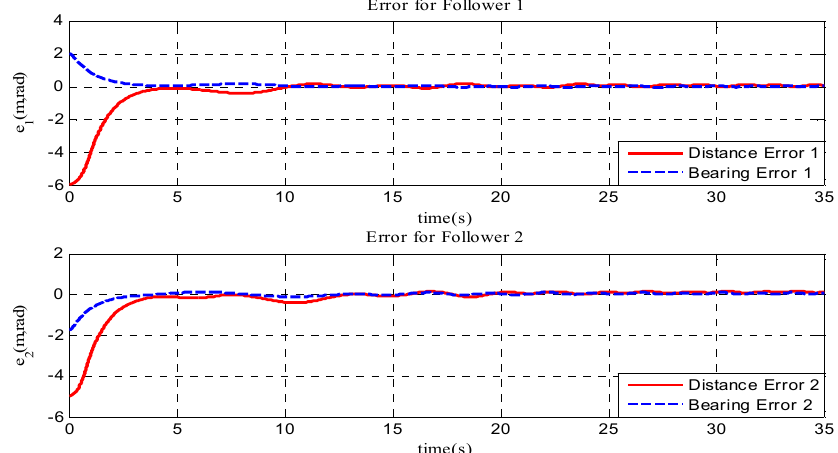
Figure 5. Relative distance and relative bearing errors of followers in Example 1.